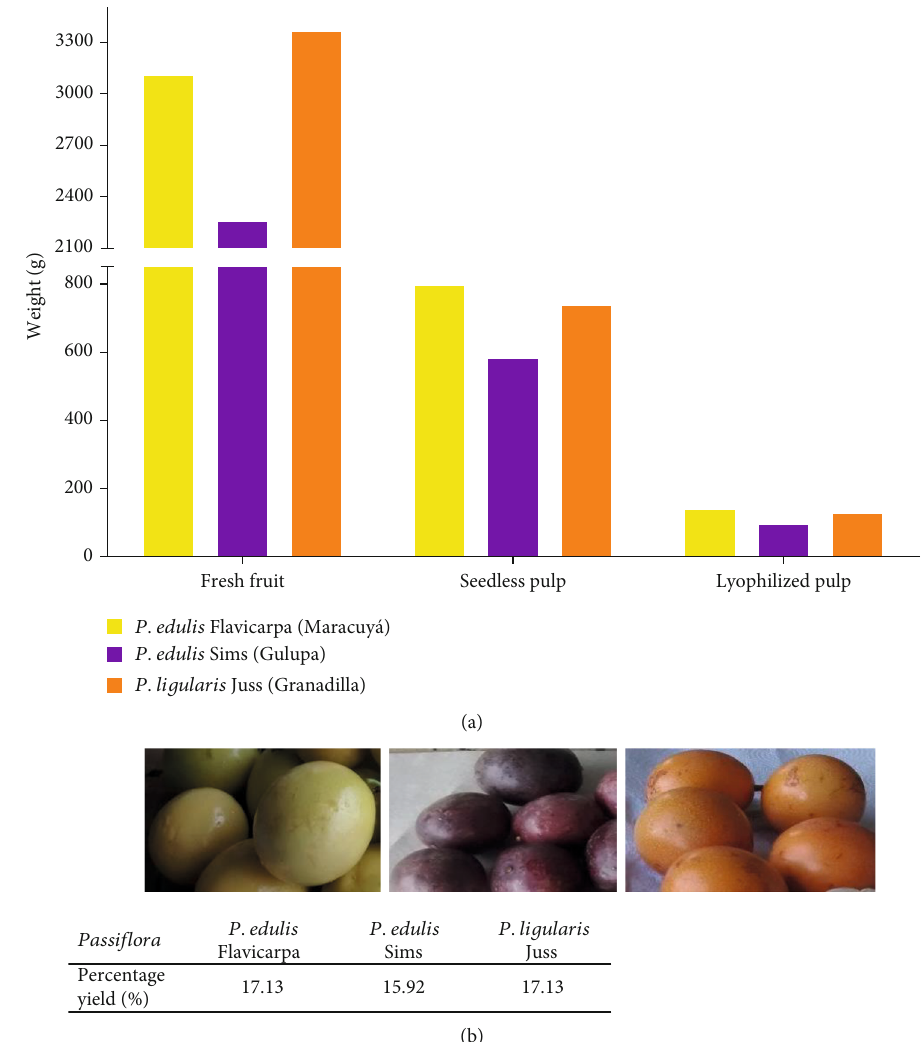
Figure 2: (a) Comparative weights of fruit treatment. (b) Pictures of fresh Colombian Passi fl oras and weight percentage yield after